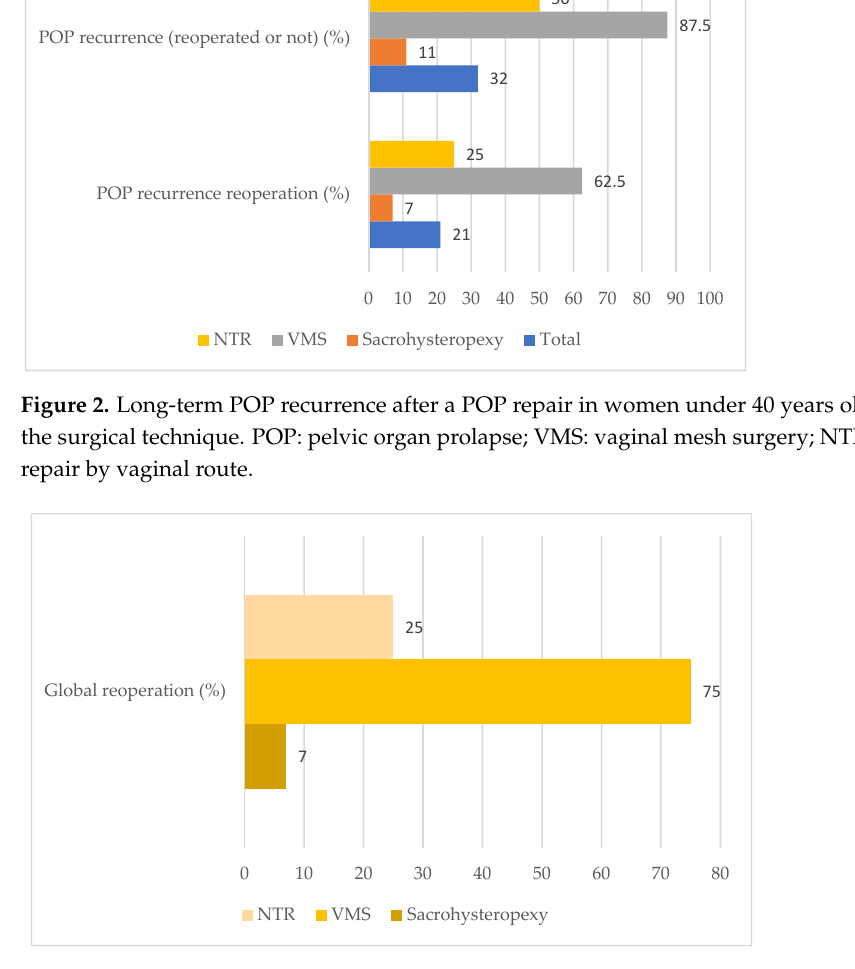
Figure 3. Global reoperation rates after a POP repair in women under 40 years old according to the surgical technique. VMS: vaginal mesh surgery; NTR: native tissue repair by vaginal route. Table 1. Population characteristics.